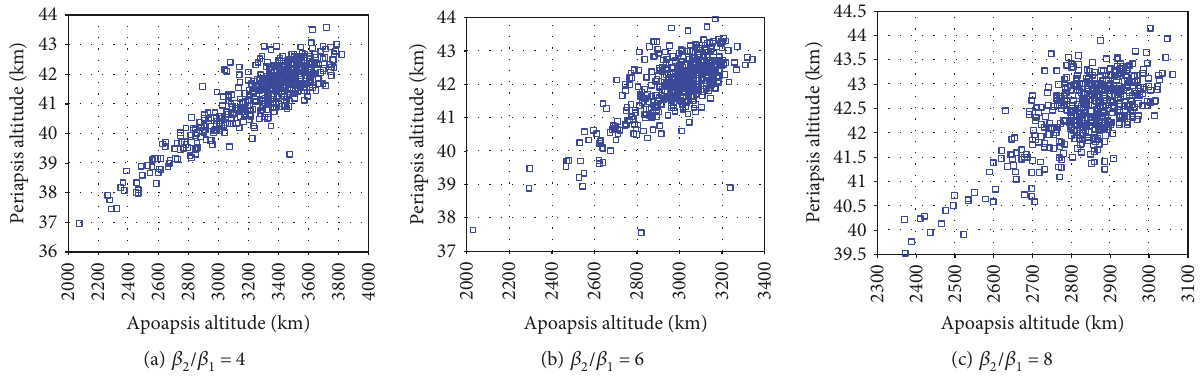
Figure 6: The distribution of periapsis and apoapsis of the captured orbit.